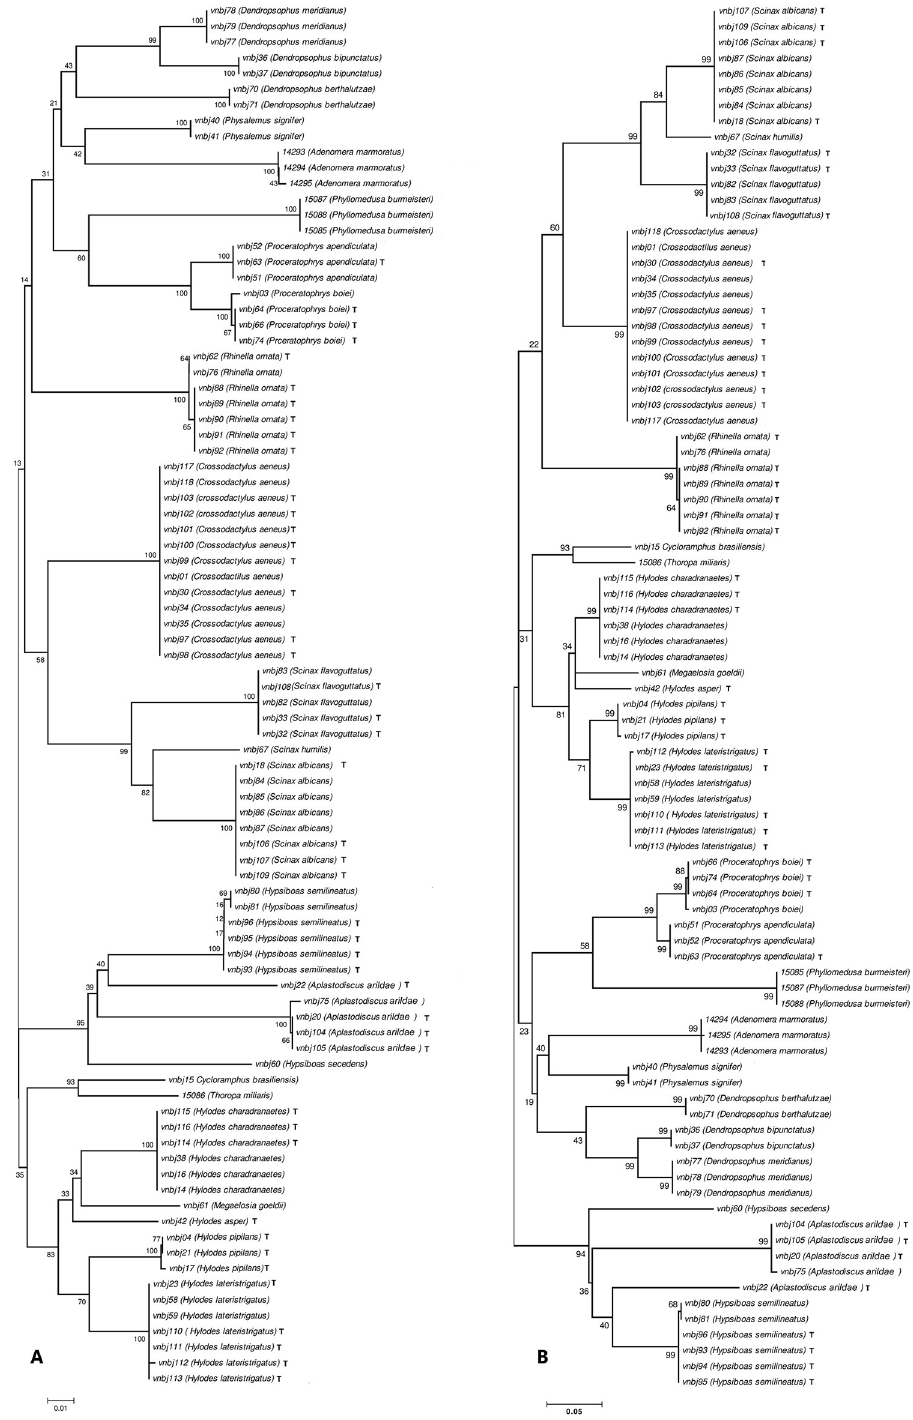
Fig 4. Neighbor-joining (A) and maximum-likelihood (B) trees of the 16S rRNA gene. Bootstrap probabilities near each internal node. Tadpoles are marked with a T after the species epithet. All remaining specimens comprise adults from the reference